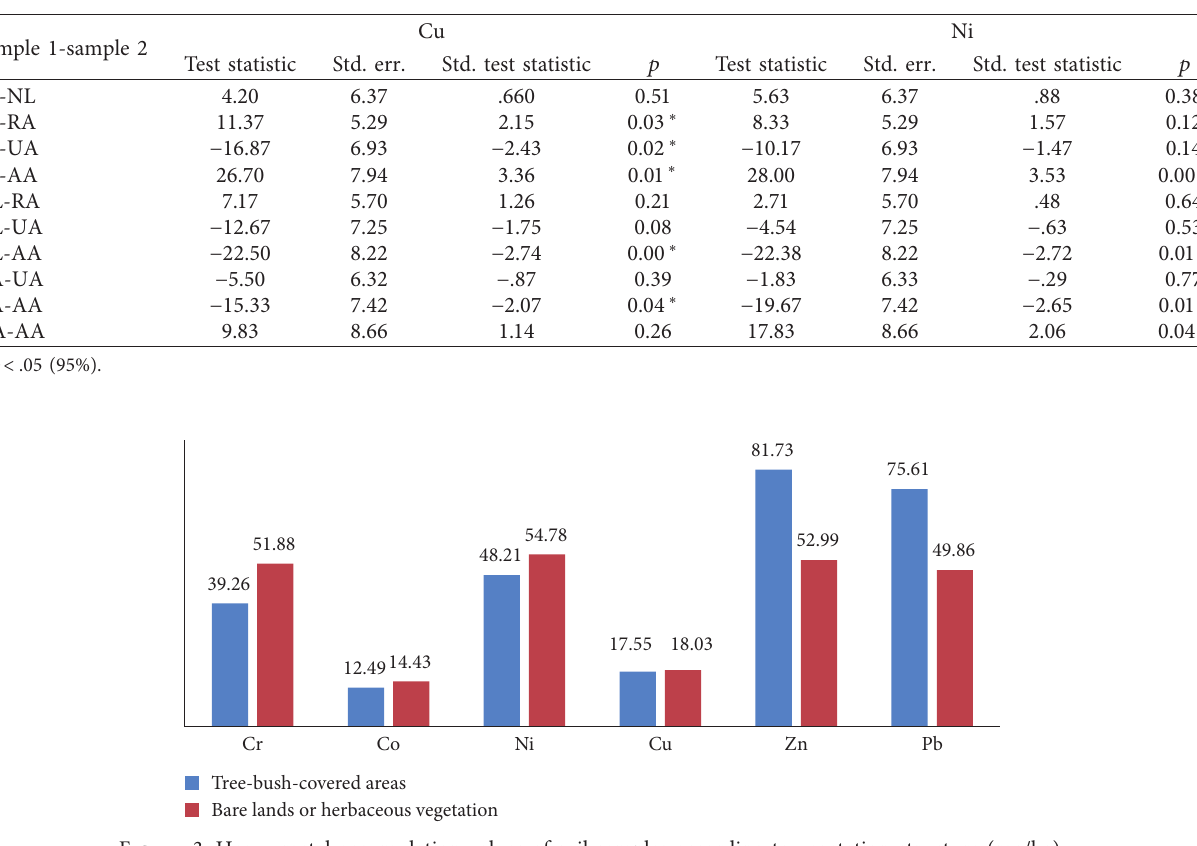
Table 5: Dunn’s test results of Cu and Ni contents.